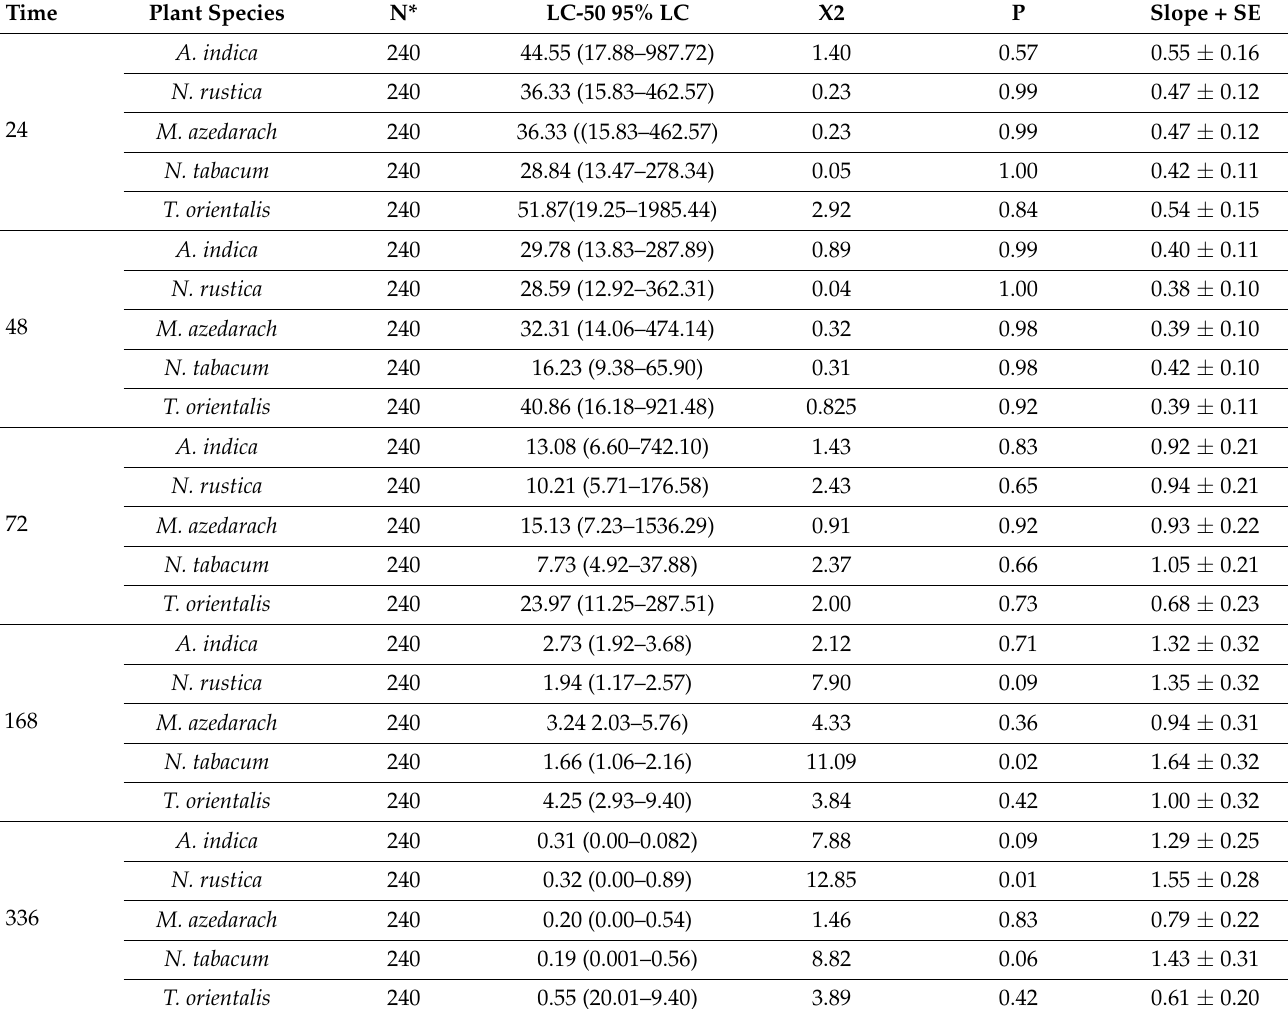
Table 5. Toxicological effect (Direct) of plant extracts against C. maculatus after 24, 48, 72, 168 and 336 h’ exposure